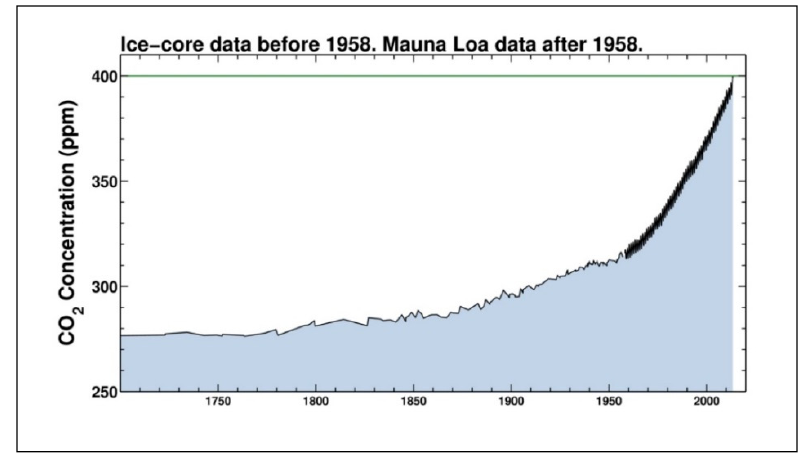
Figure 10. The Keeling Curve data, showing Earth reaching 400 parts per million of C0 2 in 2013.